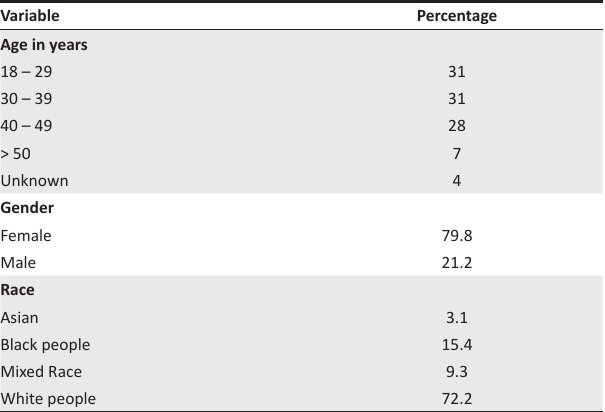
TABLE 2: Demographic information.